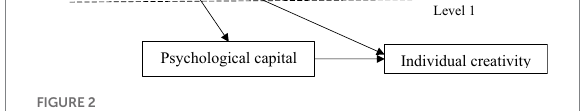
FIGURE 4 Moderating effect of QLMX between AHRP and psychological capital.